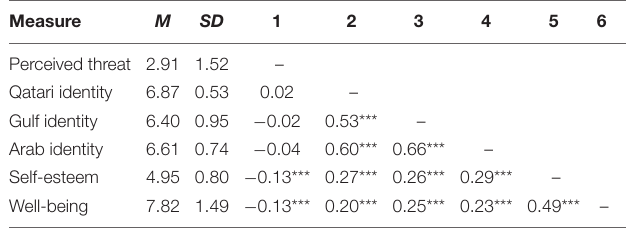
TABLE 1 | Correlations among study